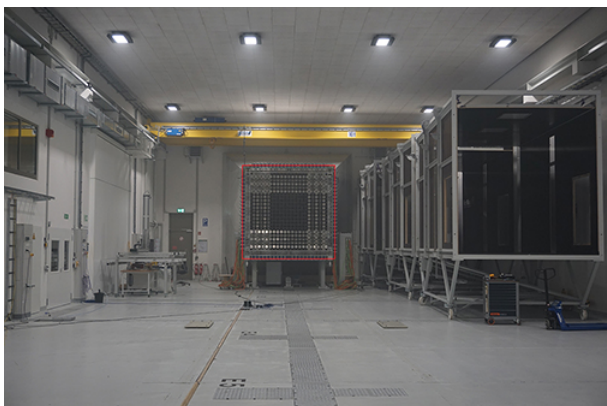
Figure 1. The open-jet wind tunnel including the active grid at the nozzle.